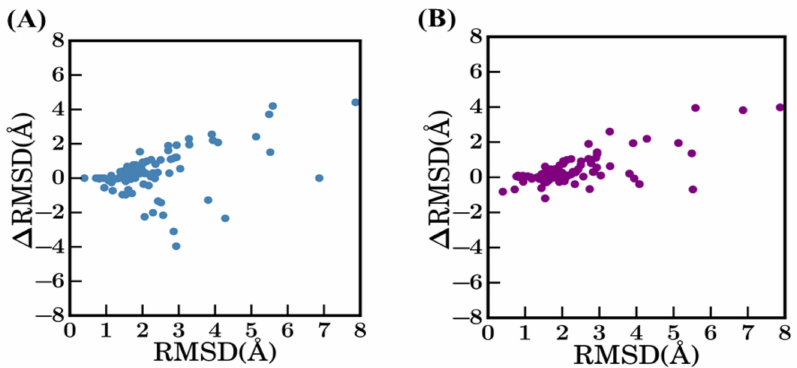
Figure A7. Comparison of scenario 1— bestSeqIdTemp with other scenarios. The RMSD of best models in Scenario 1 ( x -axis) vs. ( A ) the difference in terms of RMSD with selected models of scenario 2 and ( B ) of scenario 3 ( y